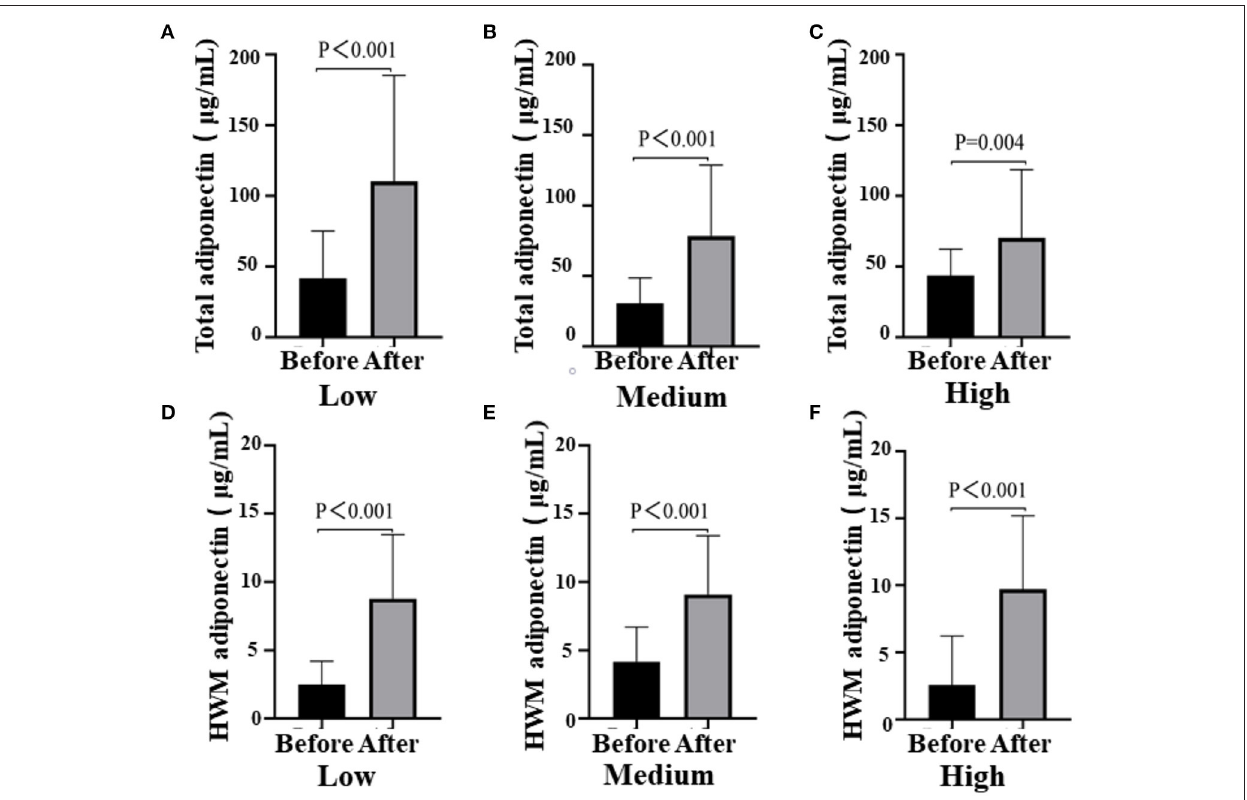
FIGURE 4 | Total adiponectin ( A , Low dose group; B , Medium dose group; C , High dose group) and HWM adiponectin levels ( D , Low dose group; E , Medium dose group; F , High dose group) before and after the intervention in the three groups, respectively. Black means total adiponectin or HWM adiponectin plasma concentration ( µ g/ml) before the intervention, gray means total adiponectin or HWM adiponectin plasma after the intervention; paired t -test used to test the difference before and after the intervention in all three